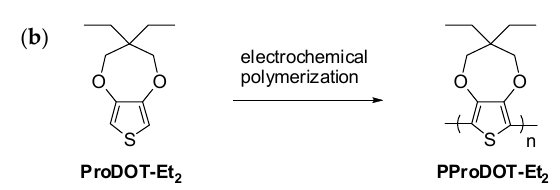
Figure 3. The electrochemical copolymerization schemes of ( a ) anodic copolymers (P(MPS- co -TTPA), P(MPO- co -TTPA), and P(ANIL- co -TTPA)) and ( b ) cathodic polymer PProDOT-Et 2 .